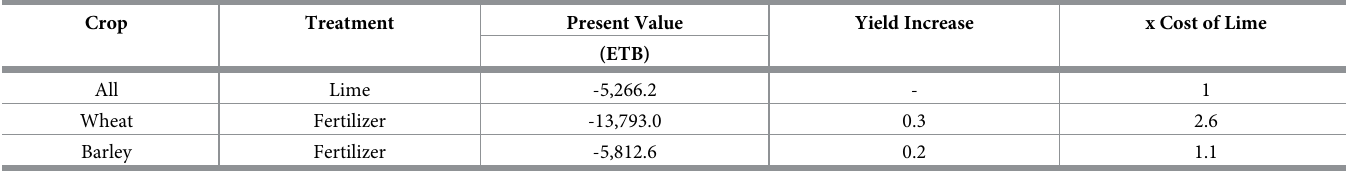
Table 5. Average present value of lime and fertilizer applications required to obtain yield increase equivalent to moving pH from 5.5 to 6.5. Crop Treatment Present Value Yield Increase x Cost of Lime (ETB) All Lime -5,266.2 Wheat Fertilizer -13,793.0 Barley Fertilizer